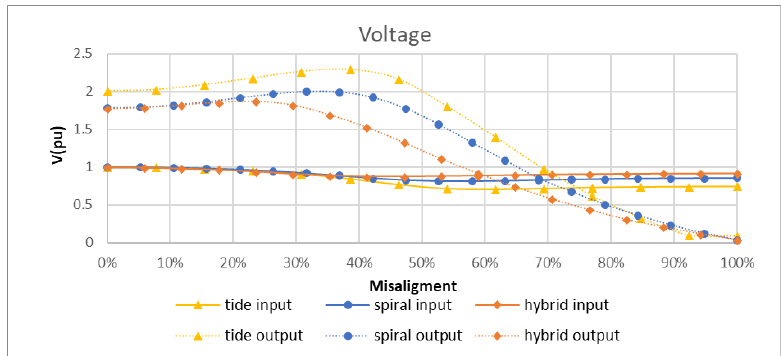
Figure 25 Figure 25. Measured voltage for primary compensation with resistive